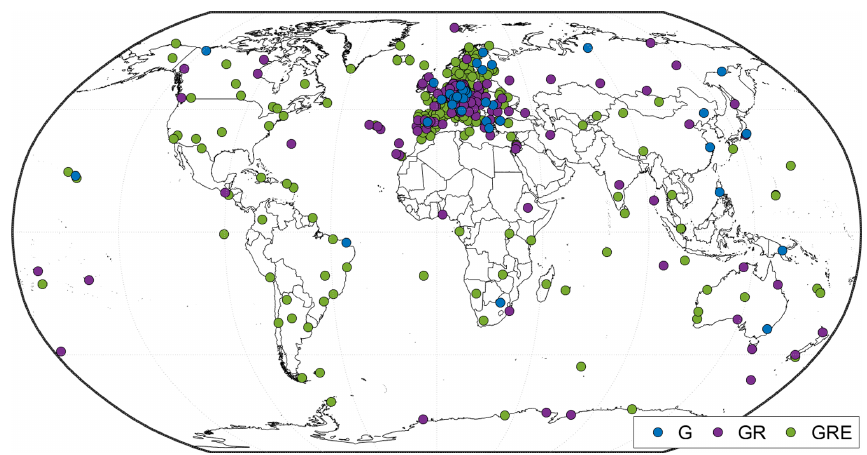
Figure 1. Global map showing all stations used in this study. The colors indicate the capability to receive signals from the particular GNSS. Table 2. Characteristics of the multi-GNSS processing at GFZ for this